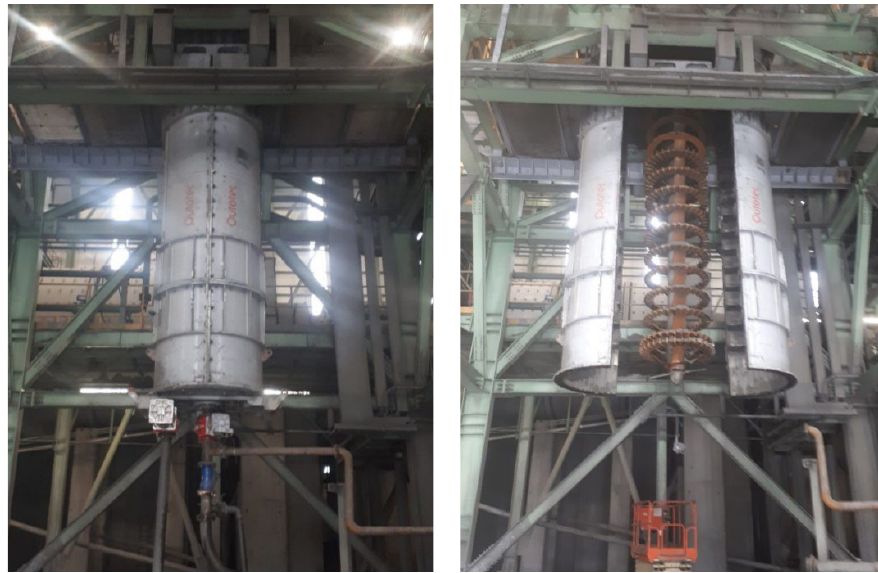
Figure 1. HIG mill at the copper mine. Table 1. Mill specifications.